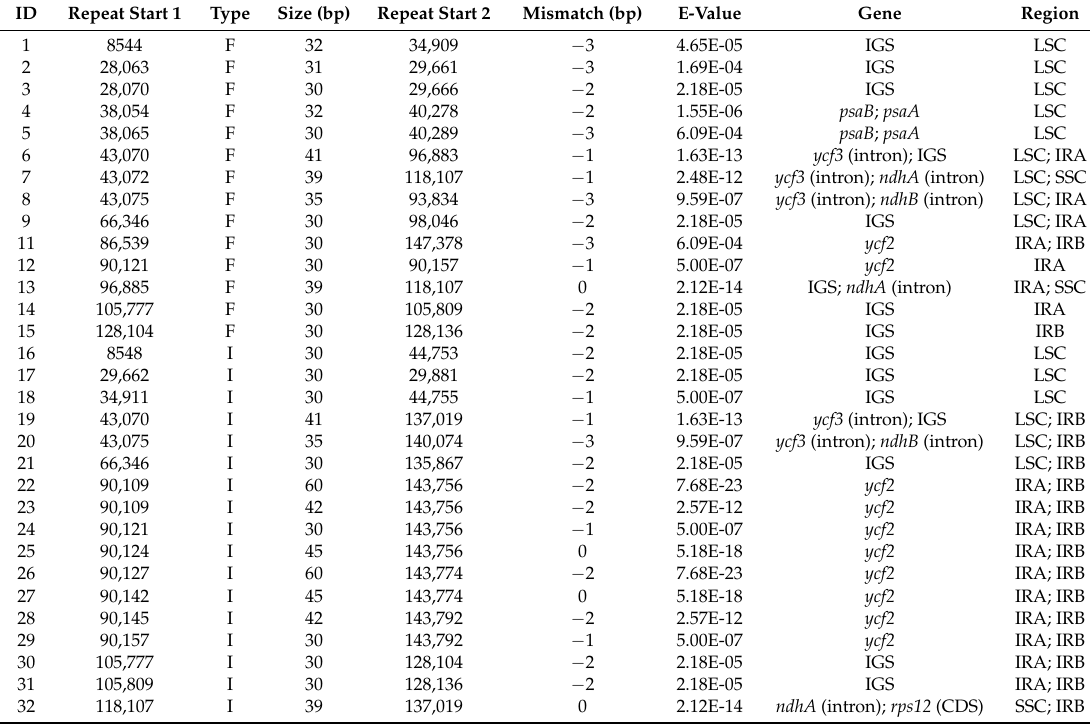
Table 4. Long repeat sequences in the A. annua chloroplast